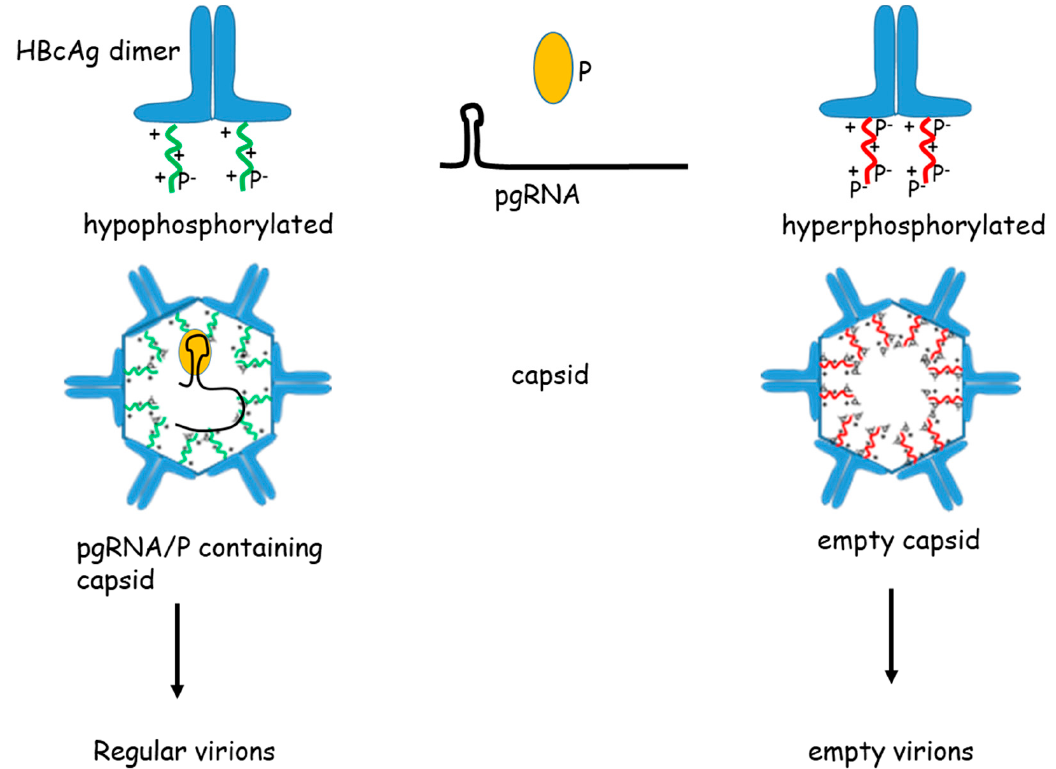
Figure 4. Capsid phosphorylation and pgRNA packaging. The schema summarizes a mechanism that hyperphosphorylation of the core protein impairs packaging of the pgRNA/polymerase (P) complex, while hypophosphorylation enables efficient packaging of the pgRNA/polymerase complex. (pg = pregenomic, P = HBV-polymerase)